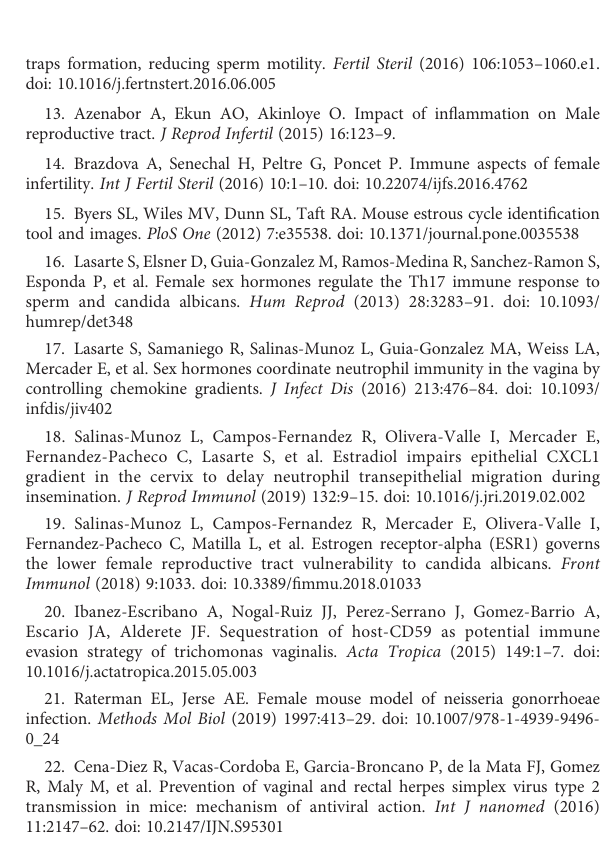
Summary of the markers used to de fi ne the cells population